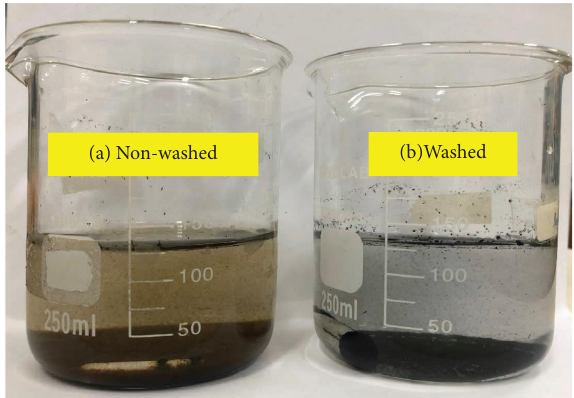
Figure 2: Color change after adding nonwashed and washed MPC- R0.2-2.0 h samples to aqueous NaOH solutions. (a) Nonwashed. (b)